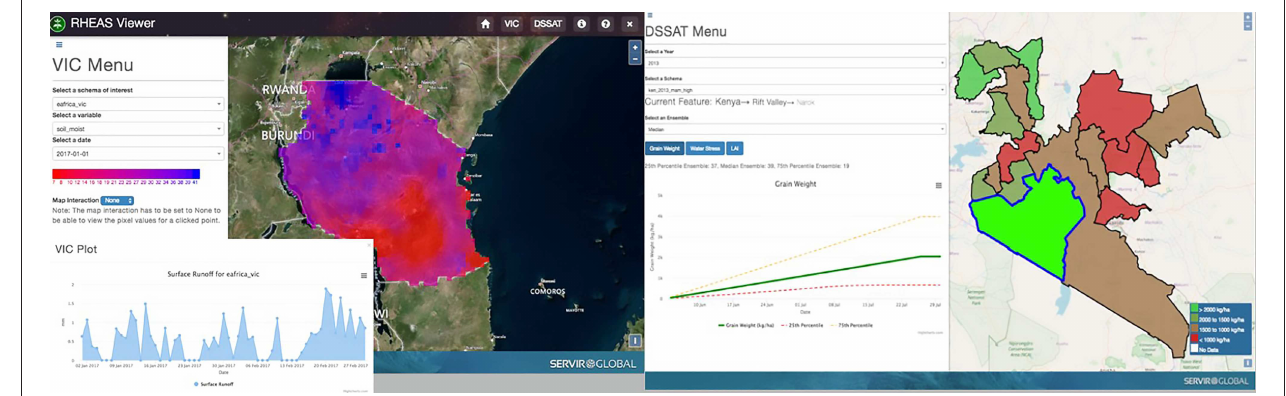
FIGURE 14 | Tethys-based application for the visualization of RHEAS outputs. The portal allows for the display and inspection of land surface outputs such as drought onset, standardized precipitation, or soil moisture (Left) and crop yield trends and water stress (Right) .